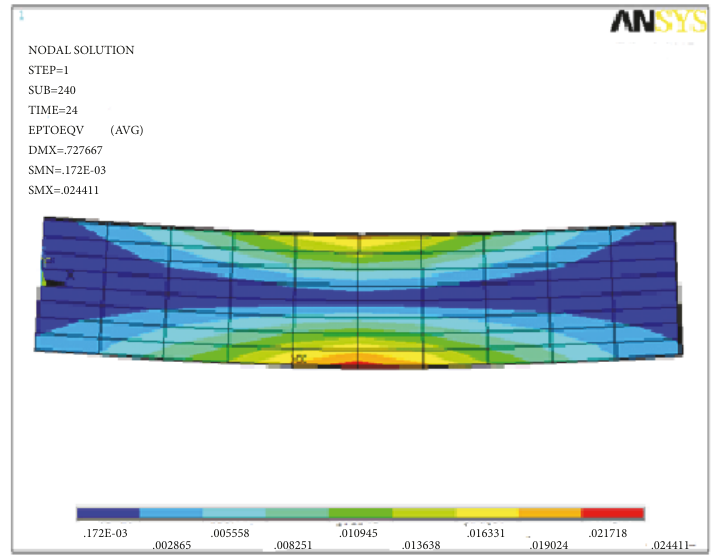
Figure 6: Plastic limited state analyzed by